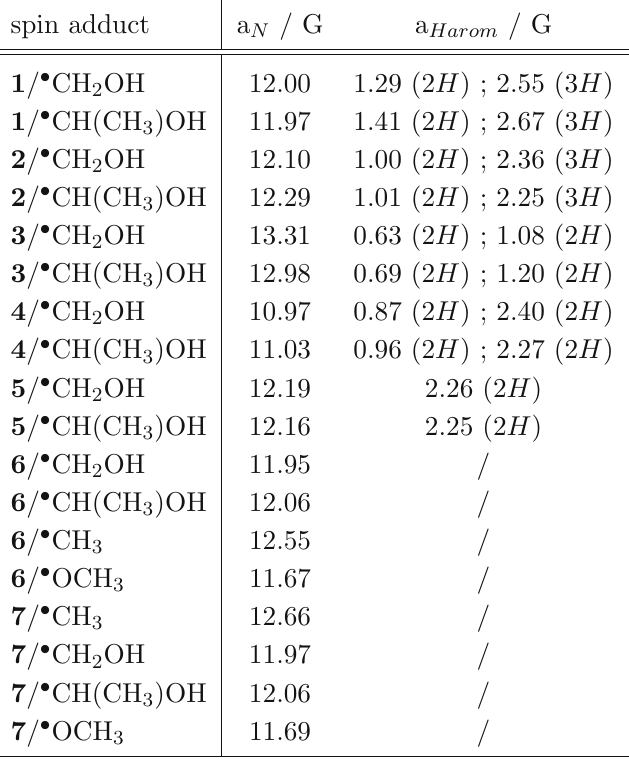
Table 2 EPR hyperfine coupling constants, a N and a Harom , for various spin adducts